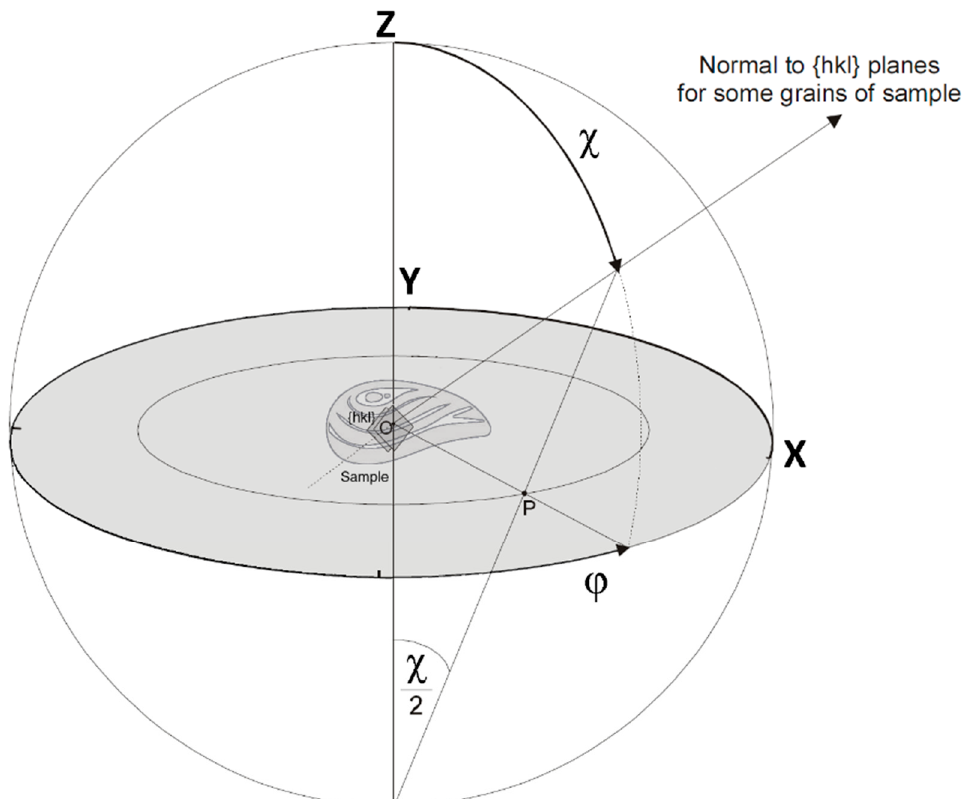
Figure 3. Pole figure construction using stereographic projection. XYZ is a Cartesian coordinate system. χ is the polar angle of a direction in the space, whereas φ is the azimuth angle. Point P is the stereographic projection of a point from the northern hemisphere.